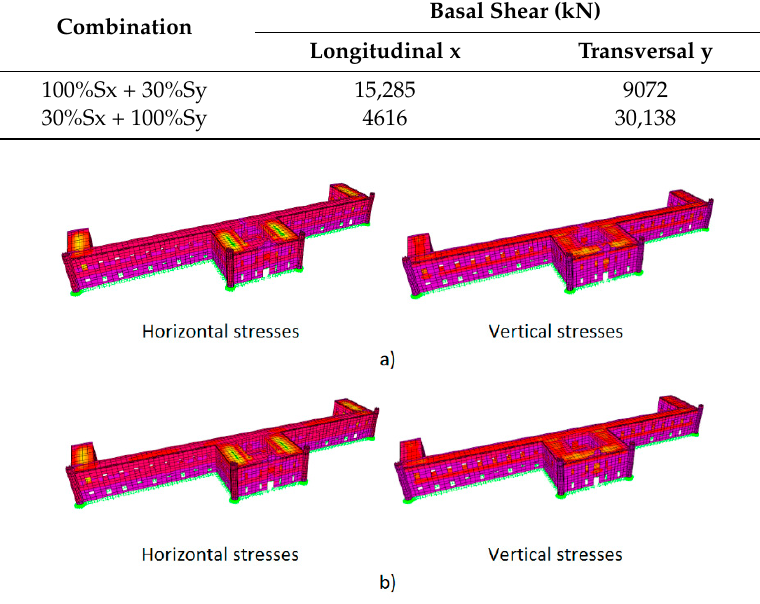
Figure 13. Map of vertical and horizontal axial stresses (MPa): ( a ) earthquake combination 100%Sx + 30%Sy; ( b ) earthquake combination 30%Sx + 100%Sy. Table 8. Base shear